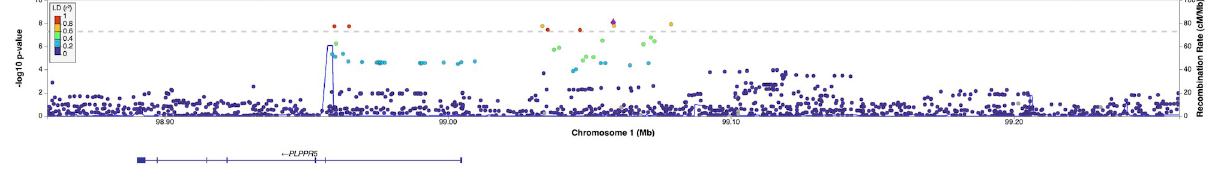
Fig 6. Local association plot of GWAS results at the PLPPR5 locus (generated with LocusZoom [48]).